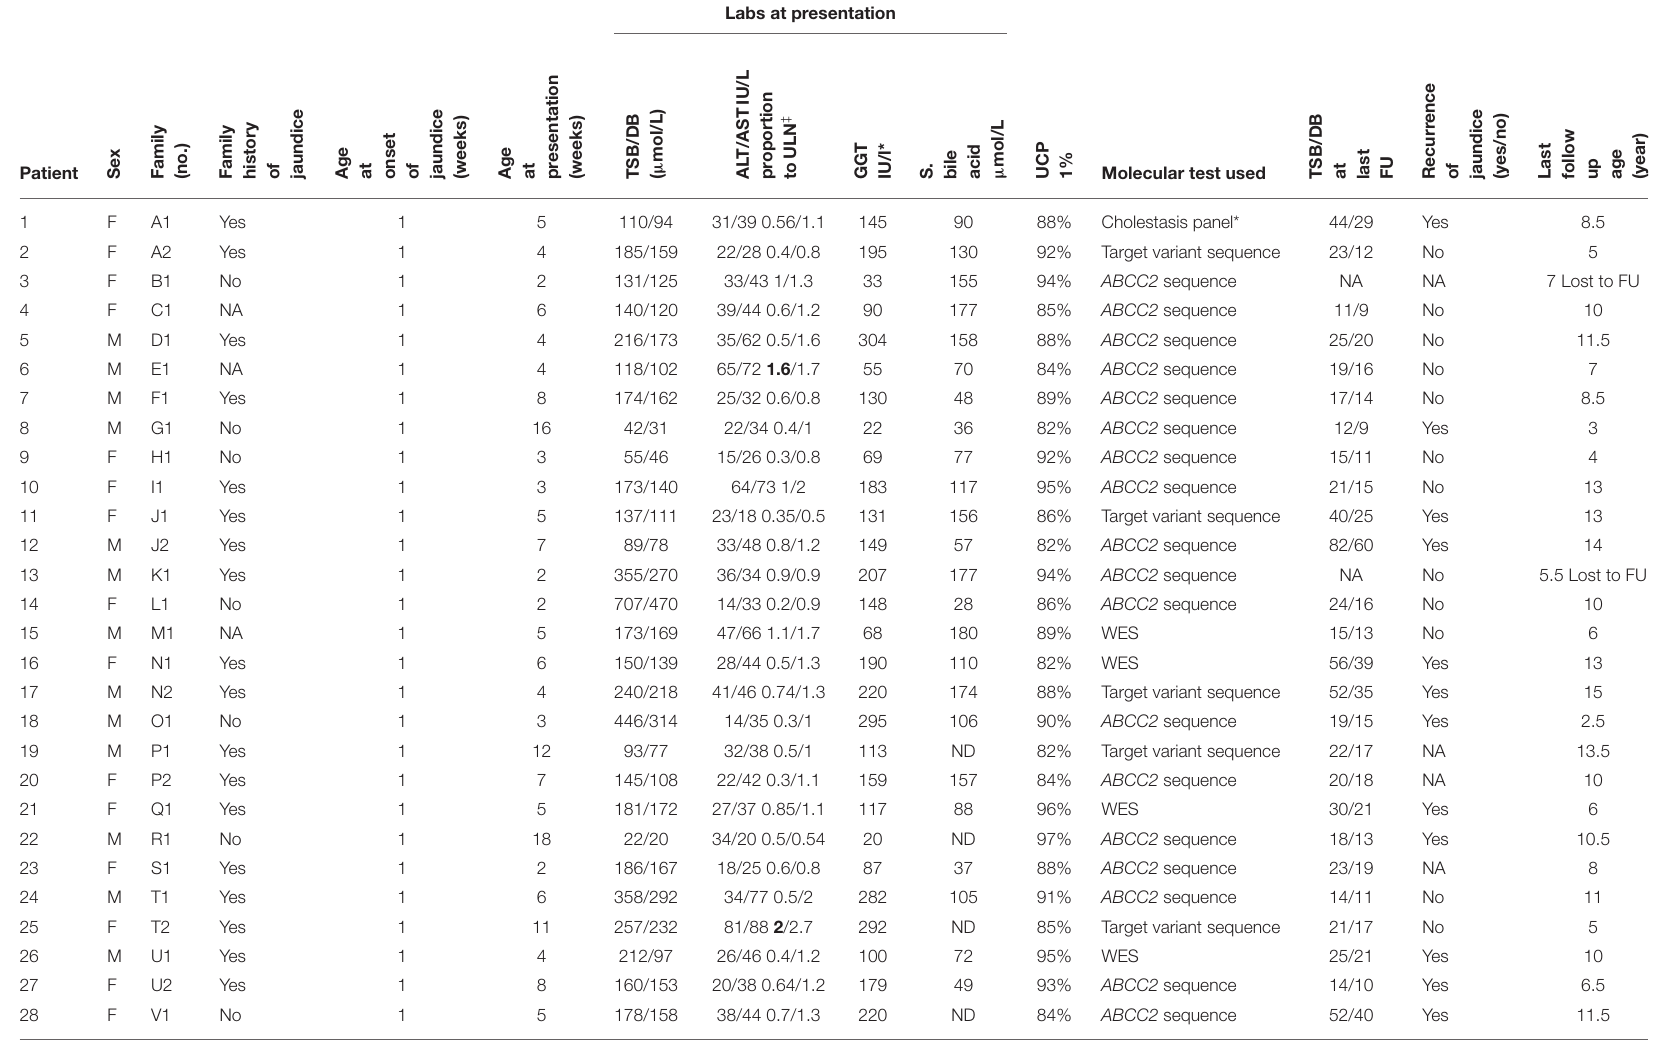
TABLE 1 | Clinical, laboratory, and molecular characteristics and outcome of the 28 patients with neonatal-onset Dubin–Johnson syndrome.